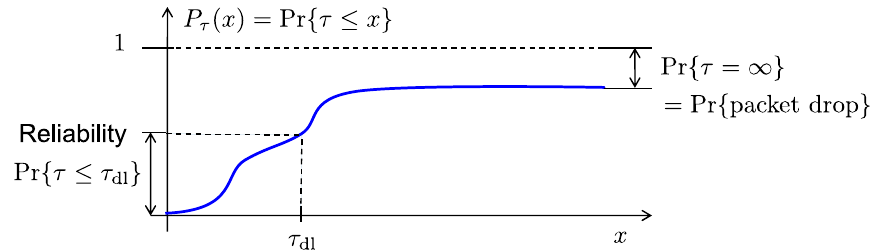
Figure 6. Illustration the Cumulative Distribution Function of the latency ( τ ) and its relationship to deadline ( τ dl ), reliability, and packet drop probability.